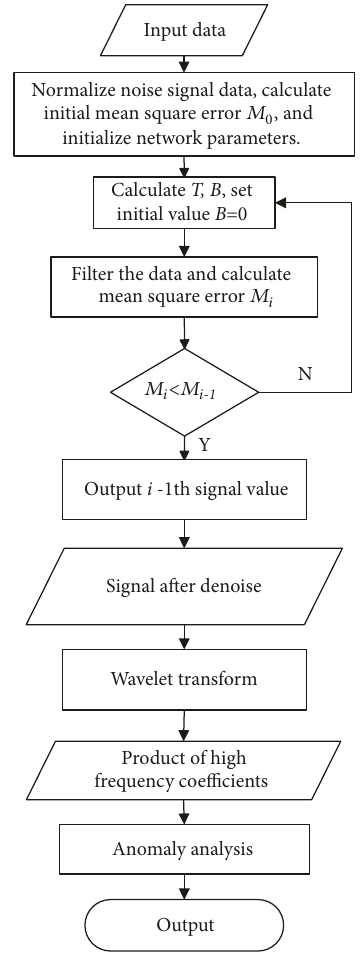
Figure 4: Flow chart of the